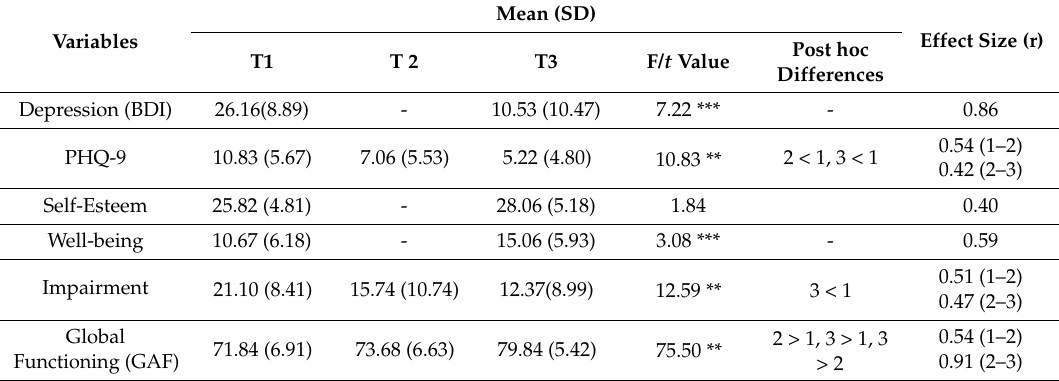
Table 4. Changes from baseline (T1) to post-assessment (T3) in completers ( n =